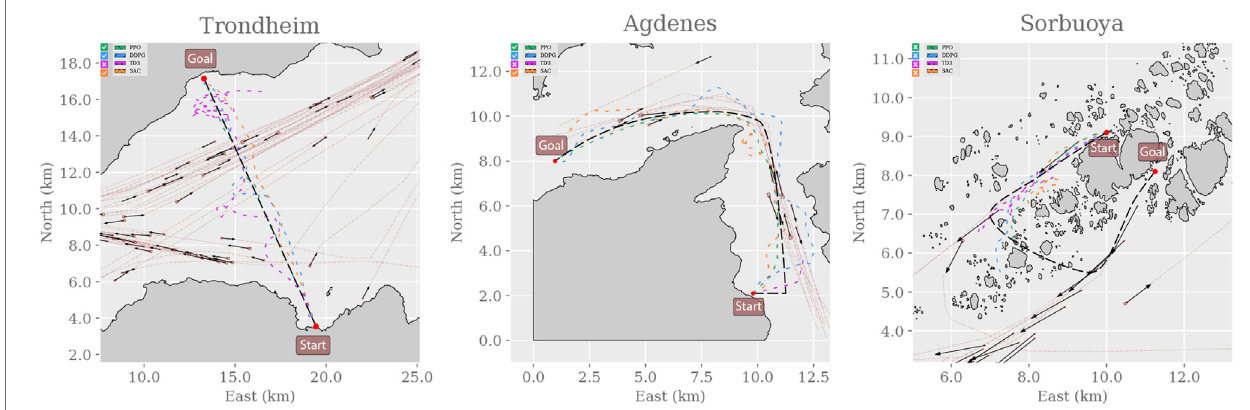
FIGURE 11 | Trajectories from evaluating the RL agents in each real-world simulation environment were sampled from the fi rst episode using a fi xed random seed (zero).Therefore,thegeneratedtraf fi cisequivalentbetweeneach algorithm,allowing thetrajectoriestobeoverlaidandcolor-codedtominimizethenumberofsubplots. Checkmarks highlight whether the agents reach the goal state in the environment. PPO, DDPG, and SAC succeeded in both Trondheim and Agdenes. TD3 failed in all scenarios,andallalgorithmsfailedinSorbuoya.InTrondheim,PPOisconsistentlyfollowingthepathfromstarttoend.SACexhibitssomedriftingtotheeast,butits trajectory is signi fi cantly less erratic than DDPG and TD3. It seems that both DDPG and TD3 avoid a crossing vessel and return to the path after the interaction. DDPG eventually reaches the goal, whereas TD3 appears too collision-avert to approach the coast and reach the goal. In Agdenes, PPO maintains the trajectory closest to the path, DDPG crosses the traf fi c and ends up maneuvering a lot to avoid collisions, TD3 collides almost instantly with a tiny vessel, and SAC generally keeps a steady coursebutstrugglestonavigatearoundtheopeningofthefjordbeforesucceeding.InSorbuoya,PPOandDDPGprogressslightlyfurtherthanTD3andSAC,whotravel back and forth looking for an entry. However, neither agent manages to fi nd a path through the densely packed islands.